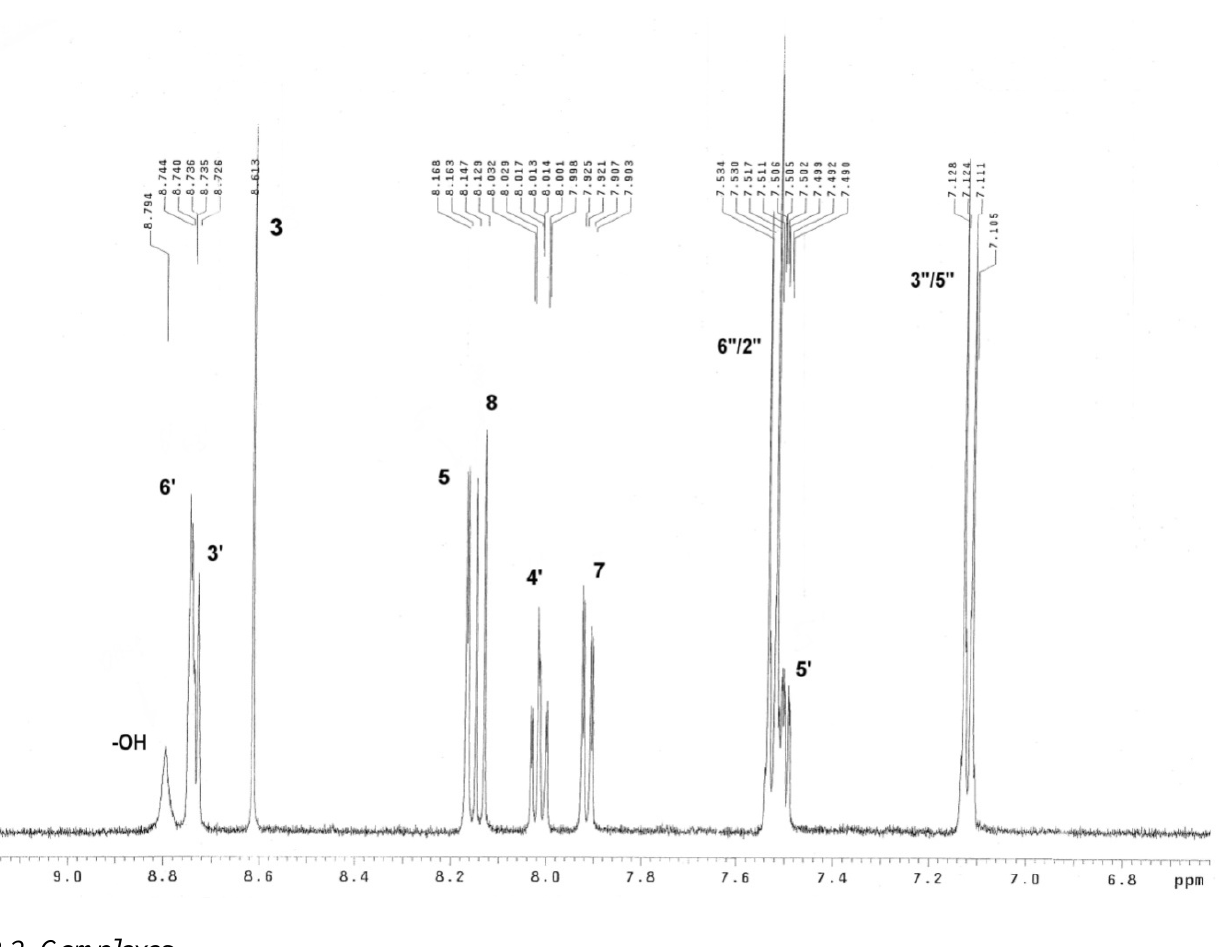
) CO) and peak assignments of ligand L 3 2